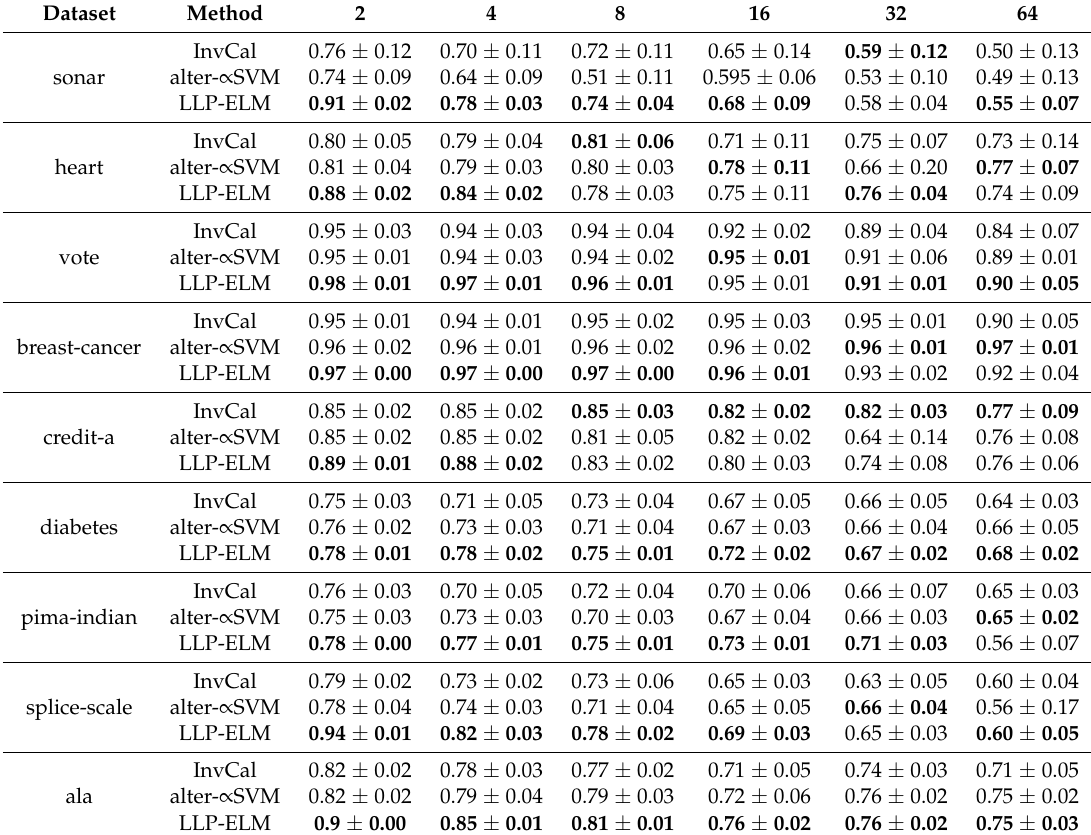
Table 2. The final results under the optimal parameters with bag size 2, 4, 8, 16, 32, 64. Bold numbers denote the best